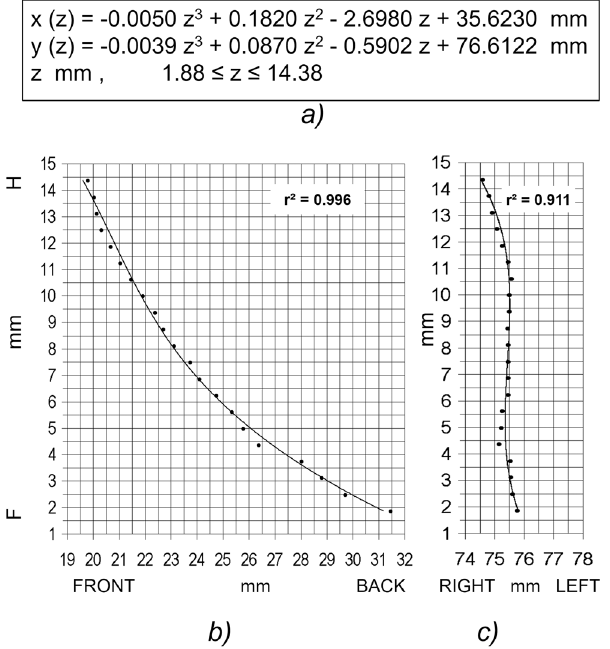
Fig 4. Fit to data of 3rd degree polynomial model (right NLC of subject #20). a) Polynomial model of the NLC axis. b) Sagittal projection. c) Coronal projection.